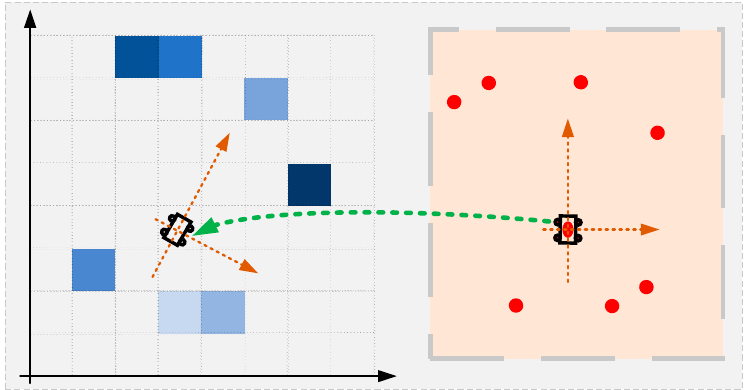
Figure 3. Mapping between scan points and grid map under a LiDAR pose. The pseudocode of the conventional CSM algorithm is shown in Algorithm 1. The function get_score finds the sum of the grids’ probability as the score under the current sensor pose, and the function CSM corresponds to the aforementioned space-searching process. It is worth mentioning that the best matching pose calculated by the CSM algorithm can only be expressed by a grid, so the center of the grid is generally used as the position information in the pose. The angles are generated in increments of the step size, so the angle accuracy in the pose is limited by the angle step size. When a higher-precision pose is required, it is necessary to improve the precision of the grid map and reduce the step size of the angle. In general, the required data amount increases quadratically with the precision of the grid map, and the number of poses for the calculated scores also increases, which will greatly increase the map’s memory overhead. Meanwhile, the brute force search requires high-performance general computing platforms, such as multi-core CPU or GPU, which are very power-hungry and not suitable for mobile and micro robots with the requirement of limited resources and constrained power budget. Algorithm 1: Conventional CSM